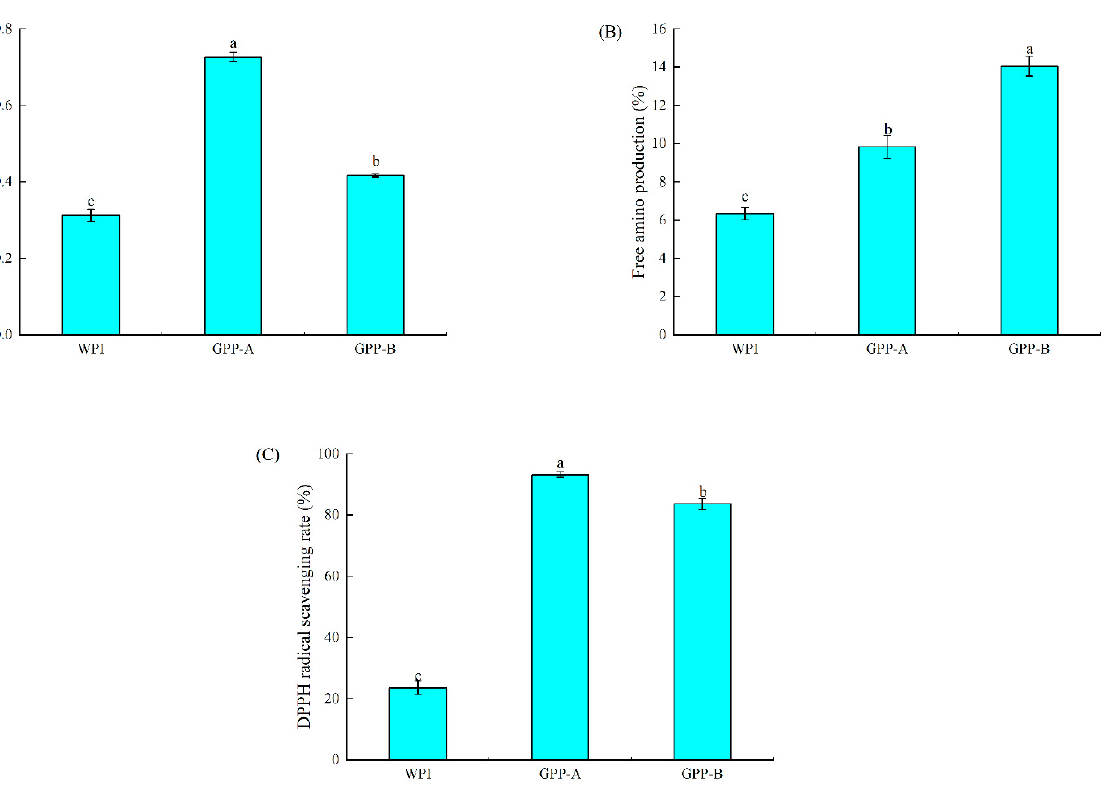
Figure 1. Changes in browning intensity ( A ); free amino production ( B ); and DPPH radical scavenge ability ( C ) of GPP-A and GPP-B. Values with different letters are significantly different ( p < 0.05).